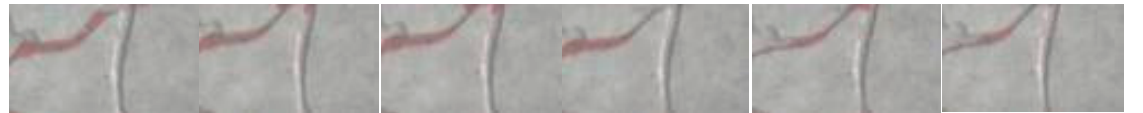
90.00%100.00% 60.00%70.00%80.00% 40.00%50.00% 20.00%30.00% Figure 17. Percentage improvement of displacement efficiency of different types of remaining oil. 0.00% 10.00% Contiguous residual oil Branched residual oil Oil film remaining oil Columnar residual oil Dropwise residual oil